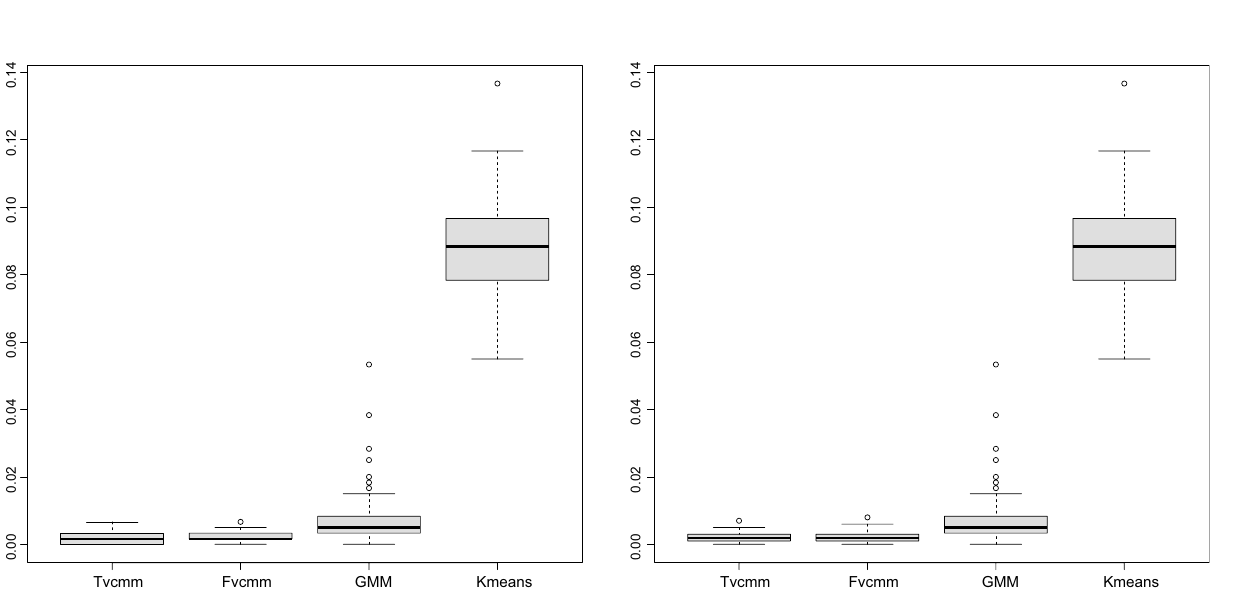
Figure 2. The box plot of the clustering performance of the fitted models for the simulated data (300) observations (left panel) and for the simulated data (500) observations (Right